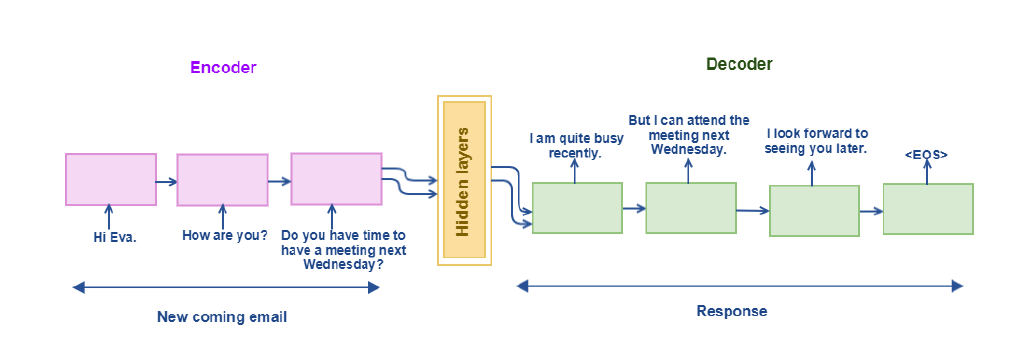
Figure 14. Ideal GRU-Sent2Vec Hybrid